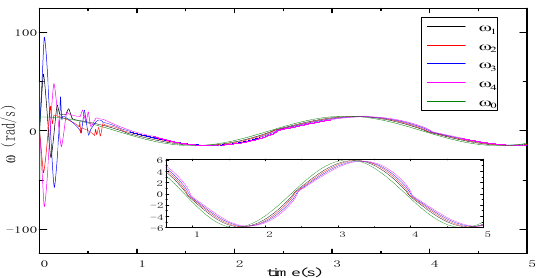
Figure 15. Compared with the consensus tracking protocol proposed in the reference [22], all motor tracking curves under the same simulation conditions: velocity signals of all